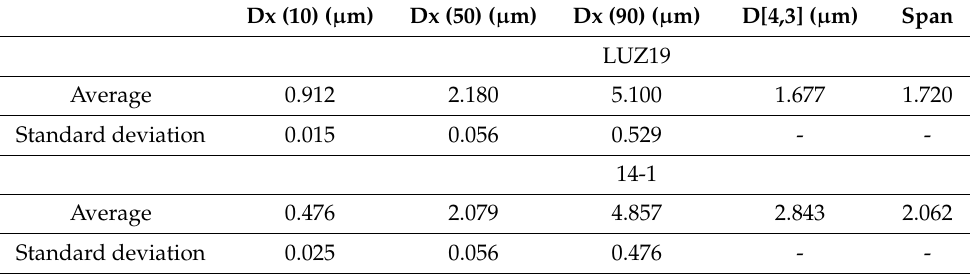
Table 1. Particle size analysis of optimal LUZ19 and 14-1 spray-dried